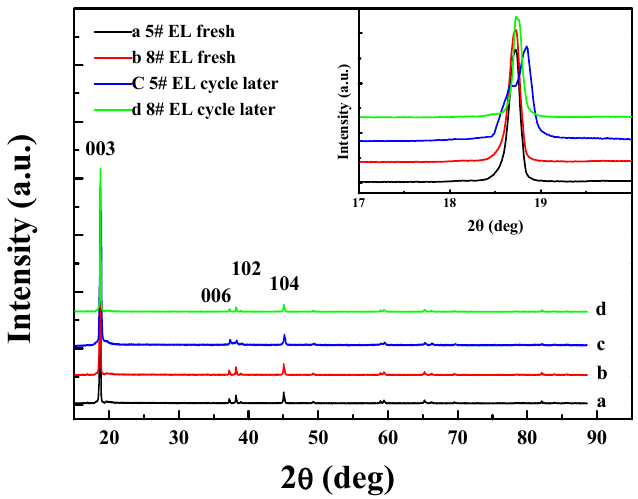
Figure 14. XRD characterizations for the positive electrodes in different electrolyte groups before and after cycle tests (The inset illustrates the narrow scan of 003).